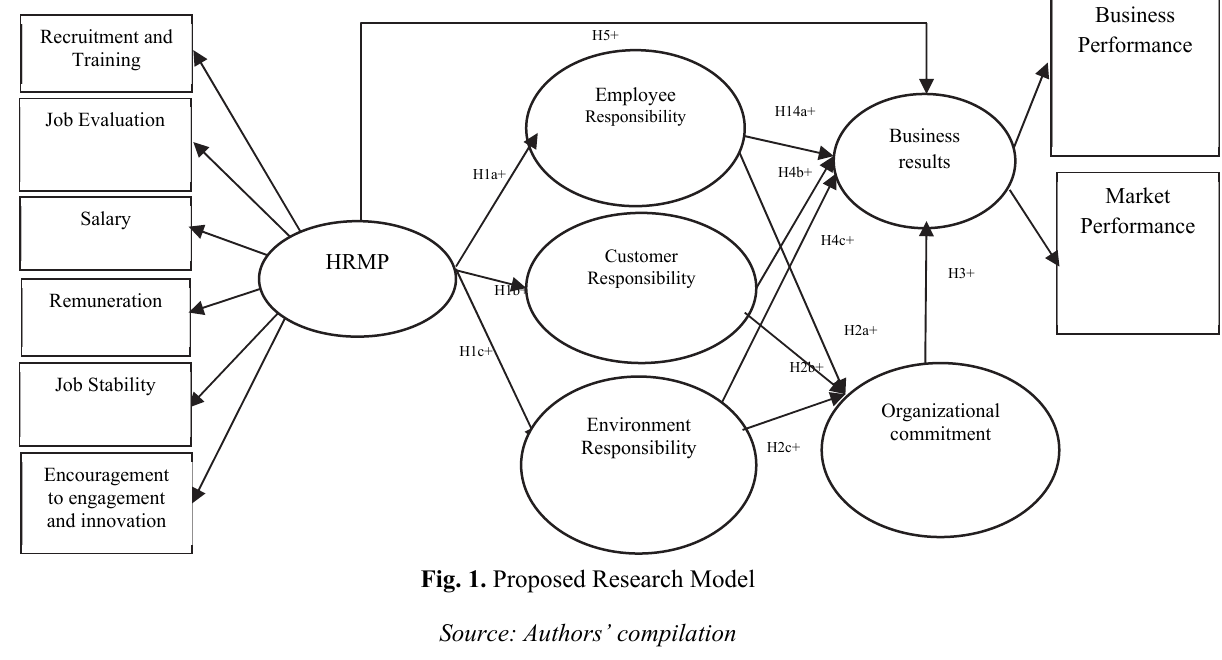
Fig. 1. Proposed Research